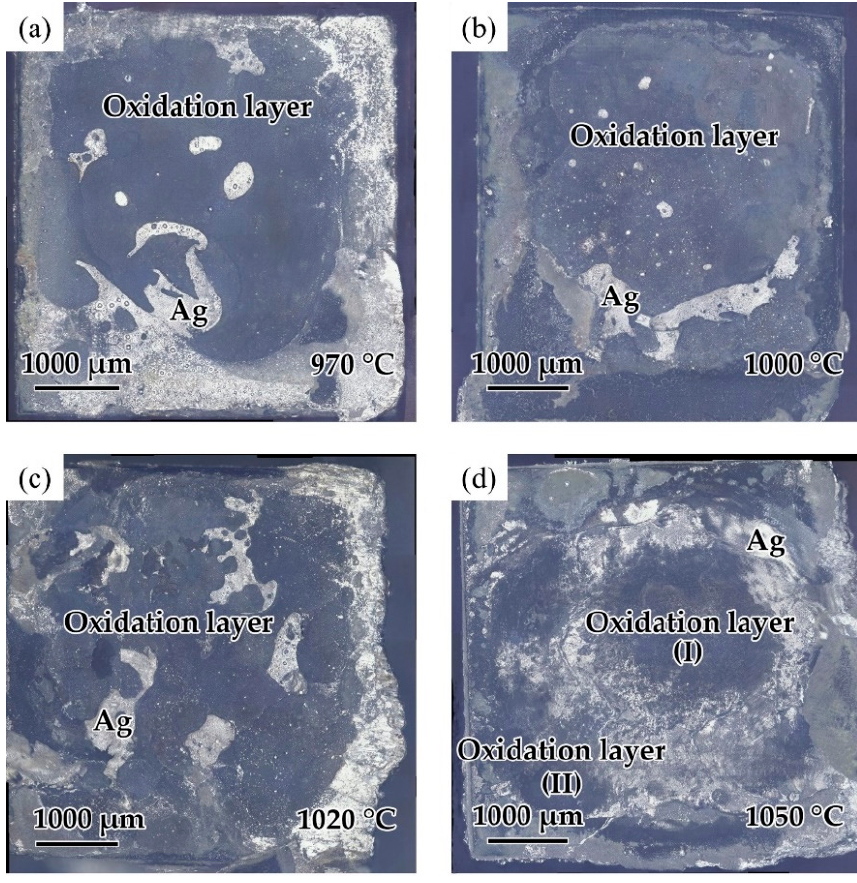
Figure 12. Fracture surfaces of the joint brazed at different temperatures for 20 min: ( a ) 970 °C, ( b ) 1000 °C, ( c ) 1020 °C, ( d ) 1050 °C.